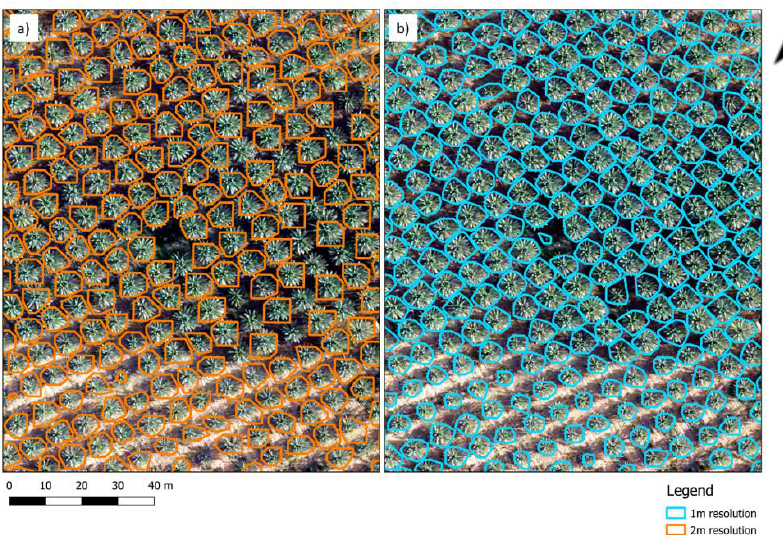
Figure 3. Section of an area of Block 5 in the farm. Canopy polygons derived using the ITC segment tool plotted in relation to the RGB data, for ( a ) the 2-m spatial resolution height raster (orange), and ( b ) 1-m spatial resolution (blue). 1-m spatial resolution